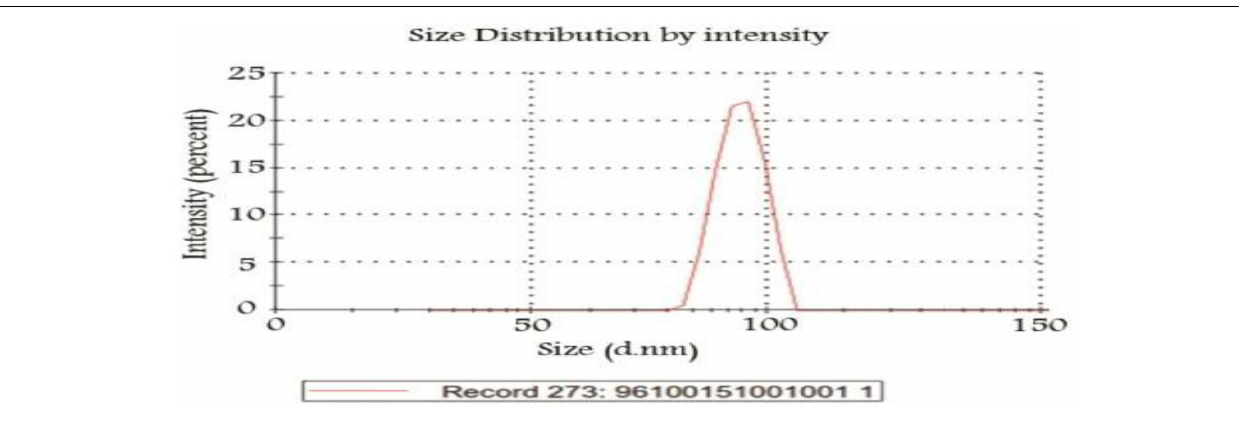
FIGURE 5 | DLS diagram of